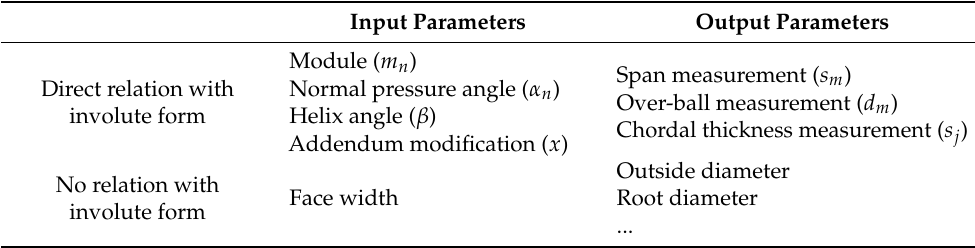
Table 1. Division of the geometrical characteristics of